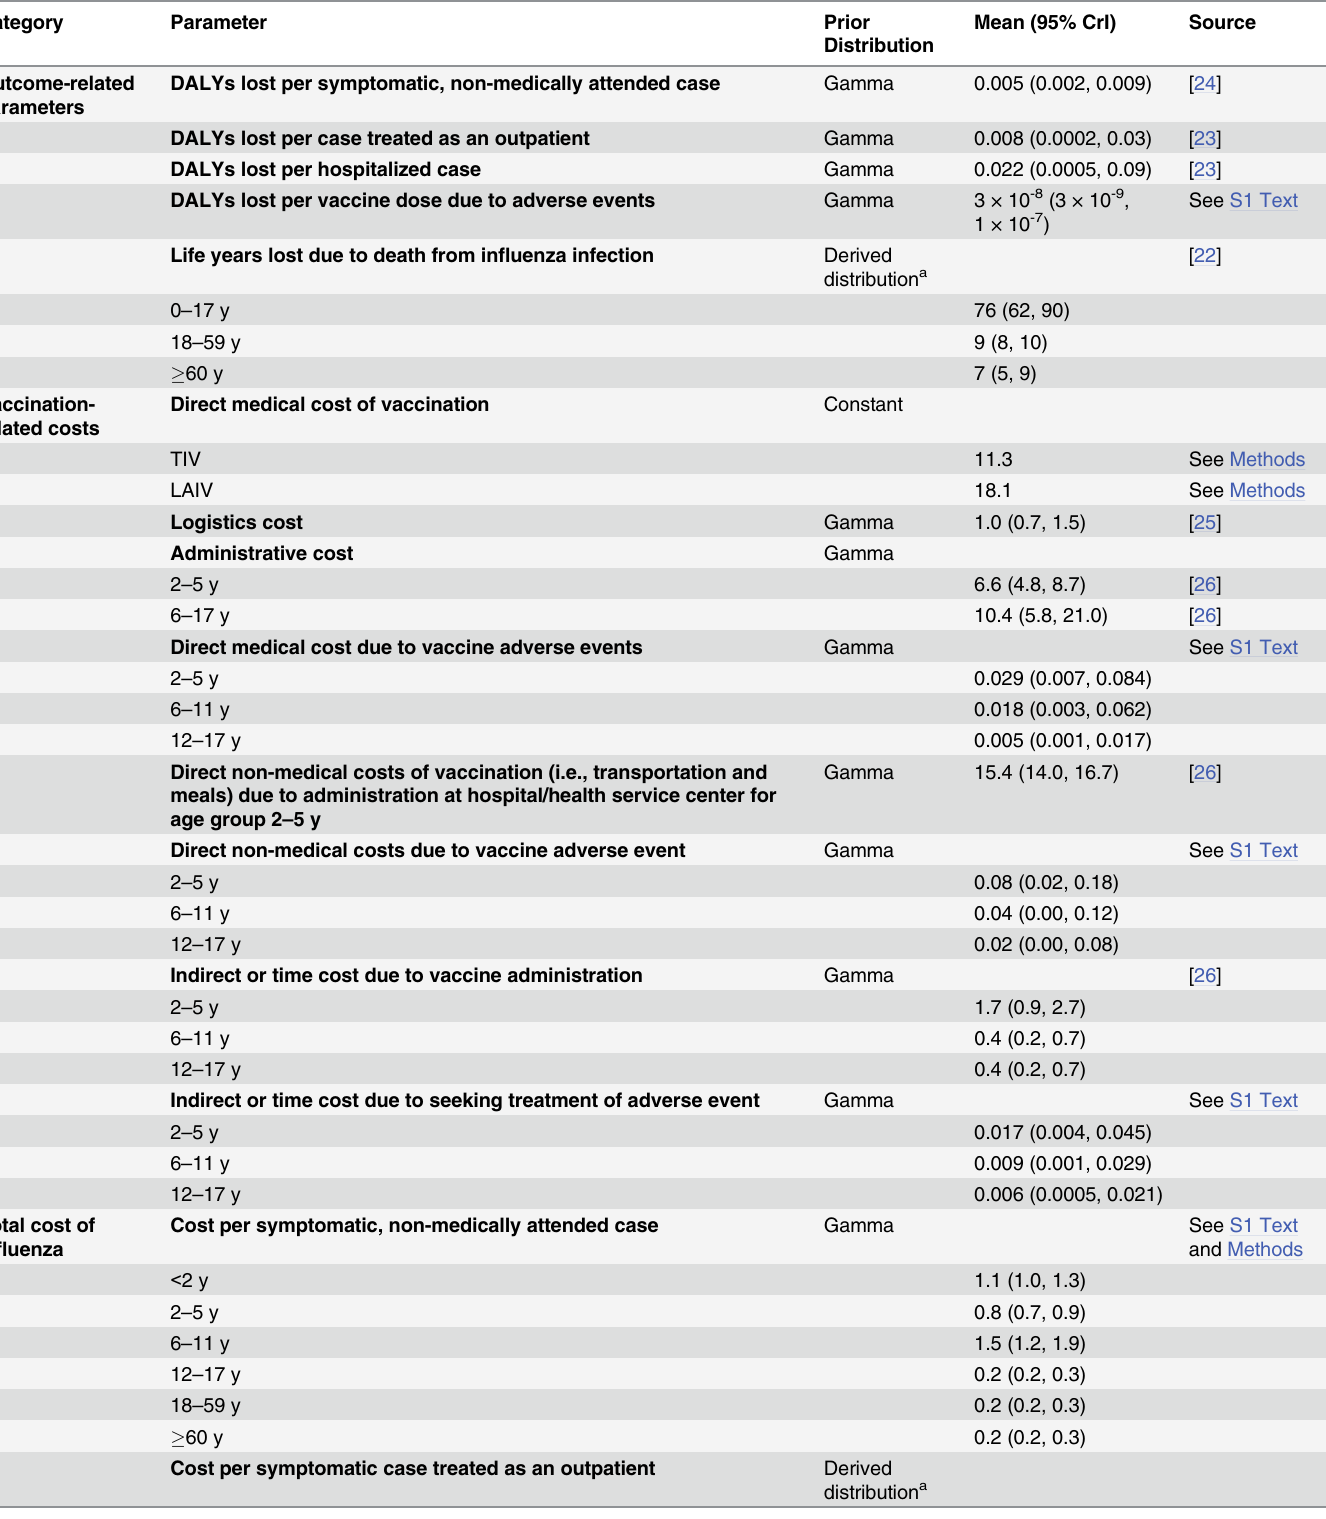
Table 4. Prior distributions for health outcome and cost parameters and their